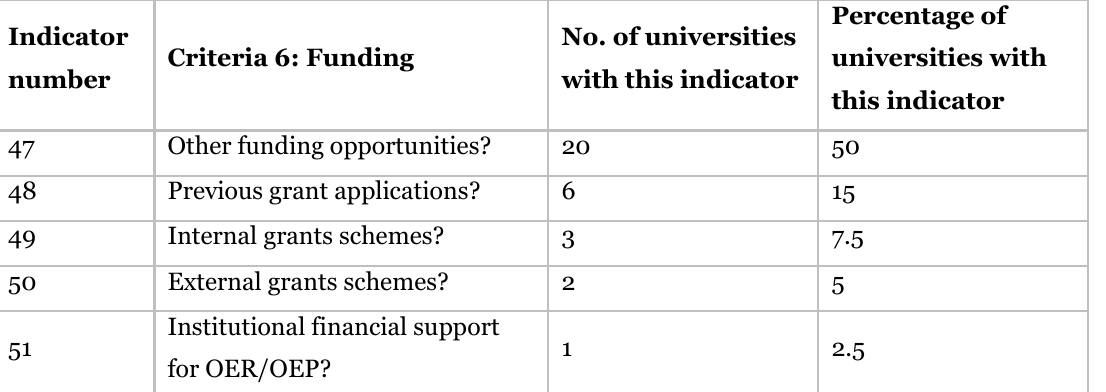
Sources of Funding for